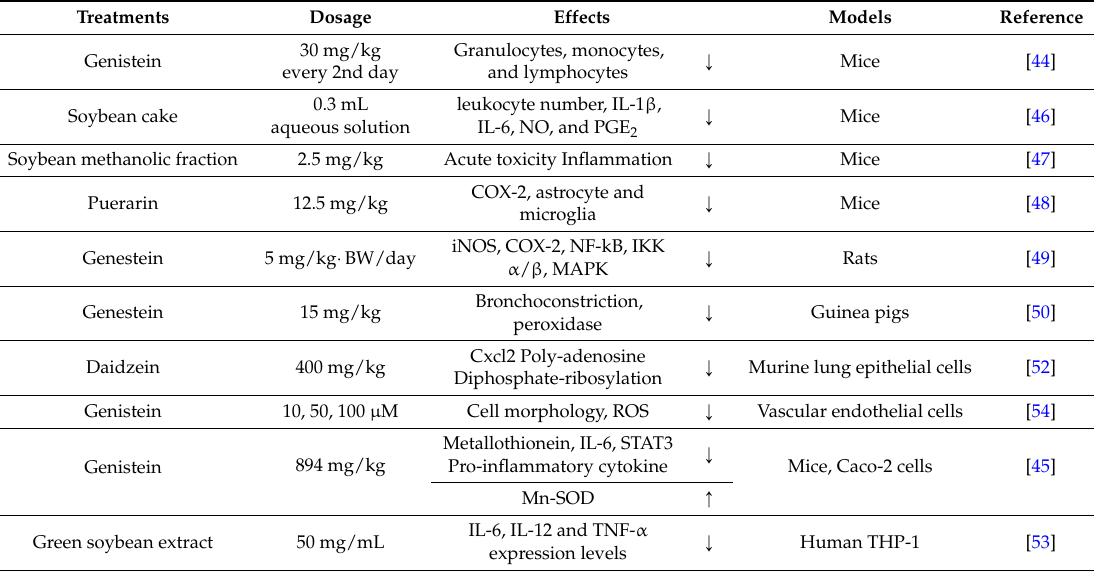
Table 2. In vivo and in vitro anti-inflammatory effects of